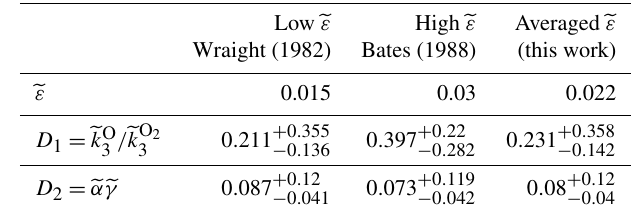
Table 3. Fitting coefficients for the combined mechanism (Eq. 5) at different efficiencies.